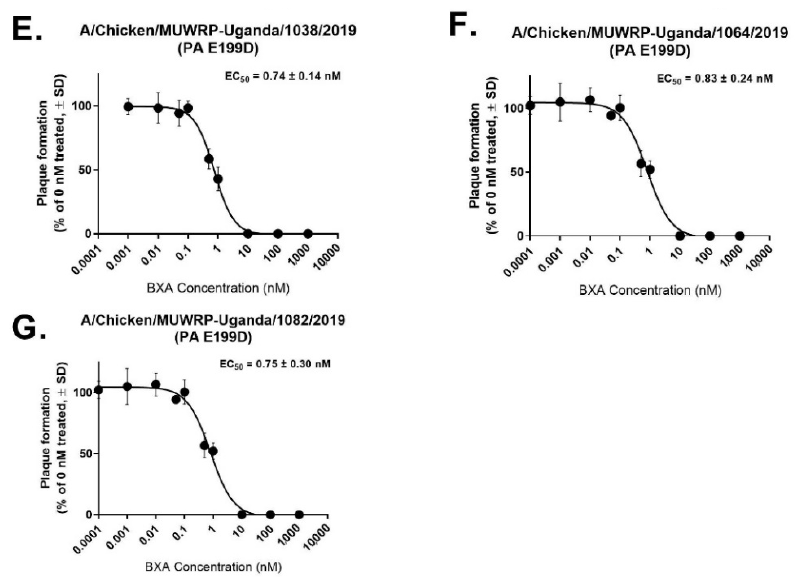
Figure 5. BXA Susceptibility of H9N2 viruses from Uganda containing the PA E199D substitution. The wild type (WT) viruses in A, B and C have EC50s ranging from 0.2-0.5nM while those with the ED substitution E, F and G have increased EC50s of 0.74-0.83nM. D. shows a virus which had